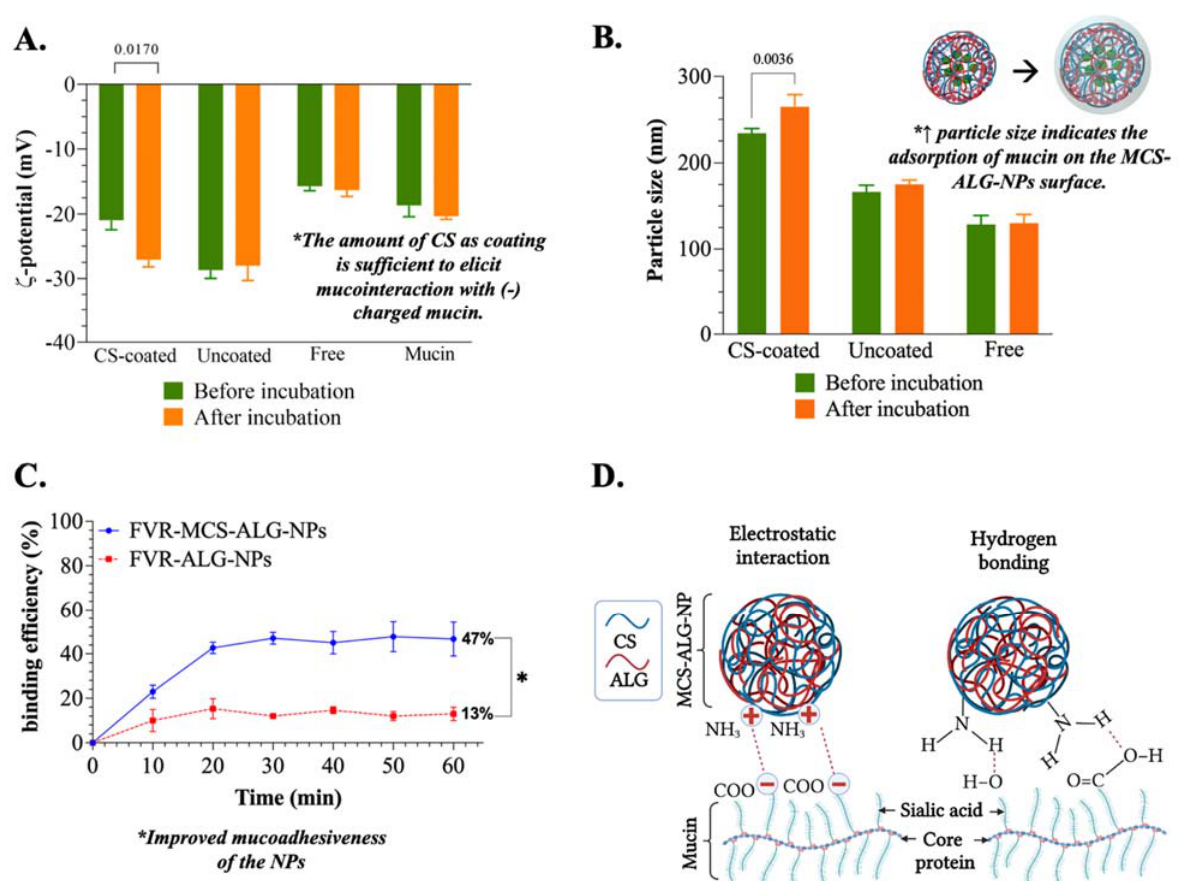
Figure 3. Mucoadhesive study: ( A ) ζ -potential and ( B ) size of the samples before and after incubation with mucin for 1 h; ( C ) mucin binding efficiency of the FVR-MCS-ALG-NPs and FVR-ALG-NPs as a function of time, n = 9 (* p = 0.0073); ( D ) illustration of the proposed mechanism of mucoadhesion of FVR-MCS-ALG-NPs.